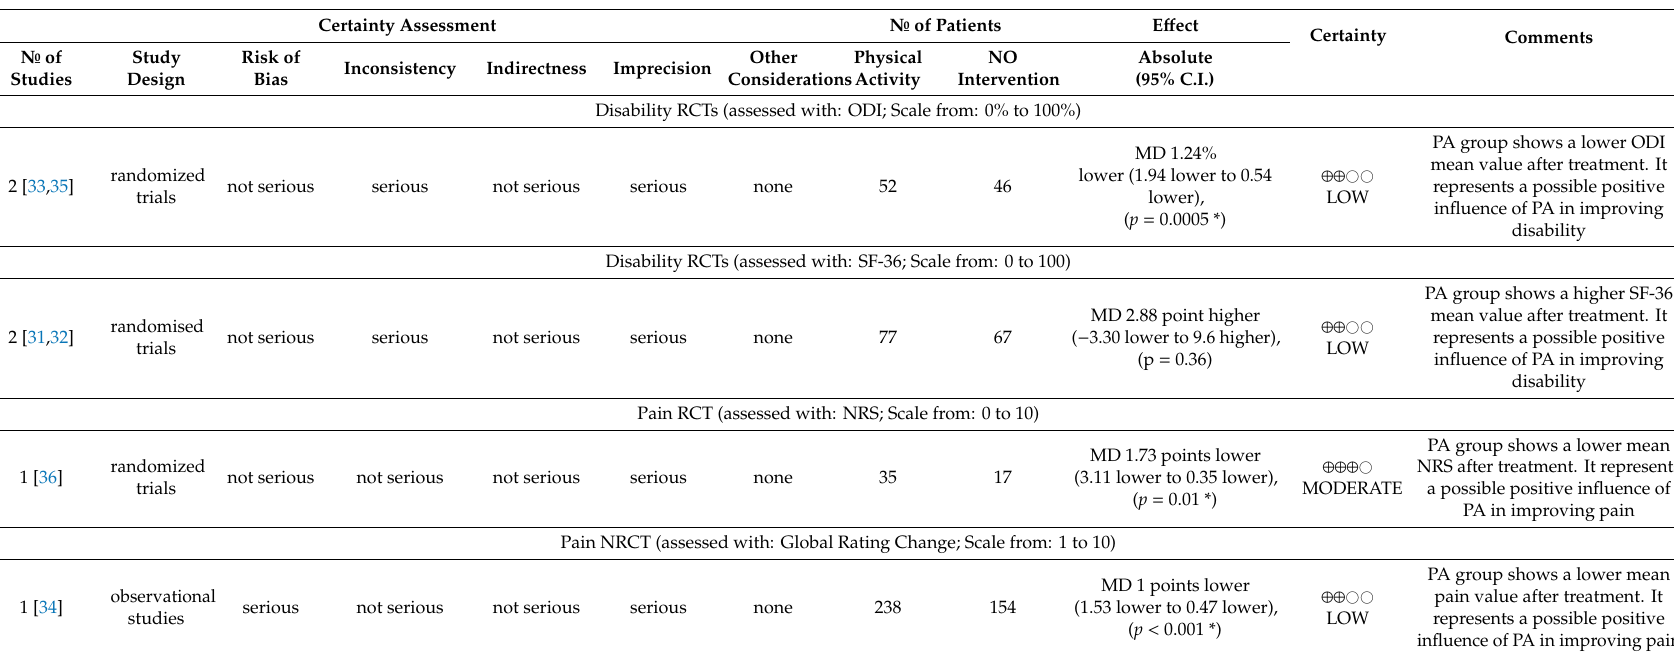
Table 3. GRADE evidence